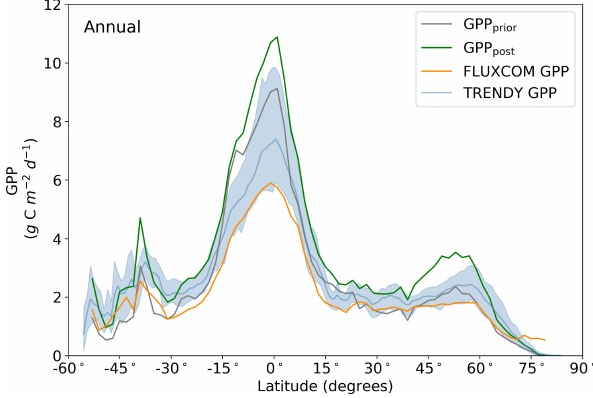
Figure 10. Annual latitudinal averages of GPP prior (gray line), GPP post (green line), FLUXCOM GPP (orange line), TRENDY model average (light blue line) and TRENDY model spread given by the 10th and 90th percentiles (light blue shading).